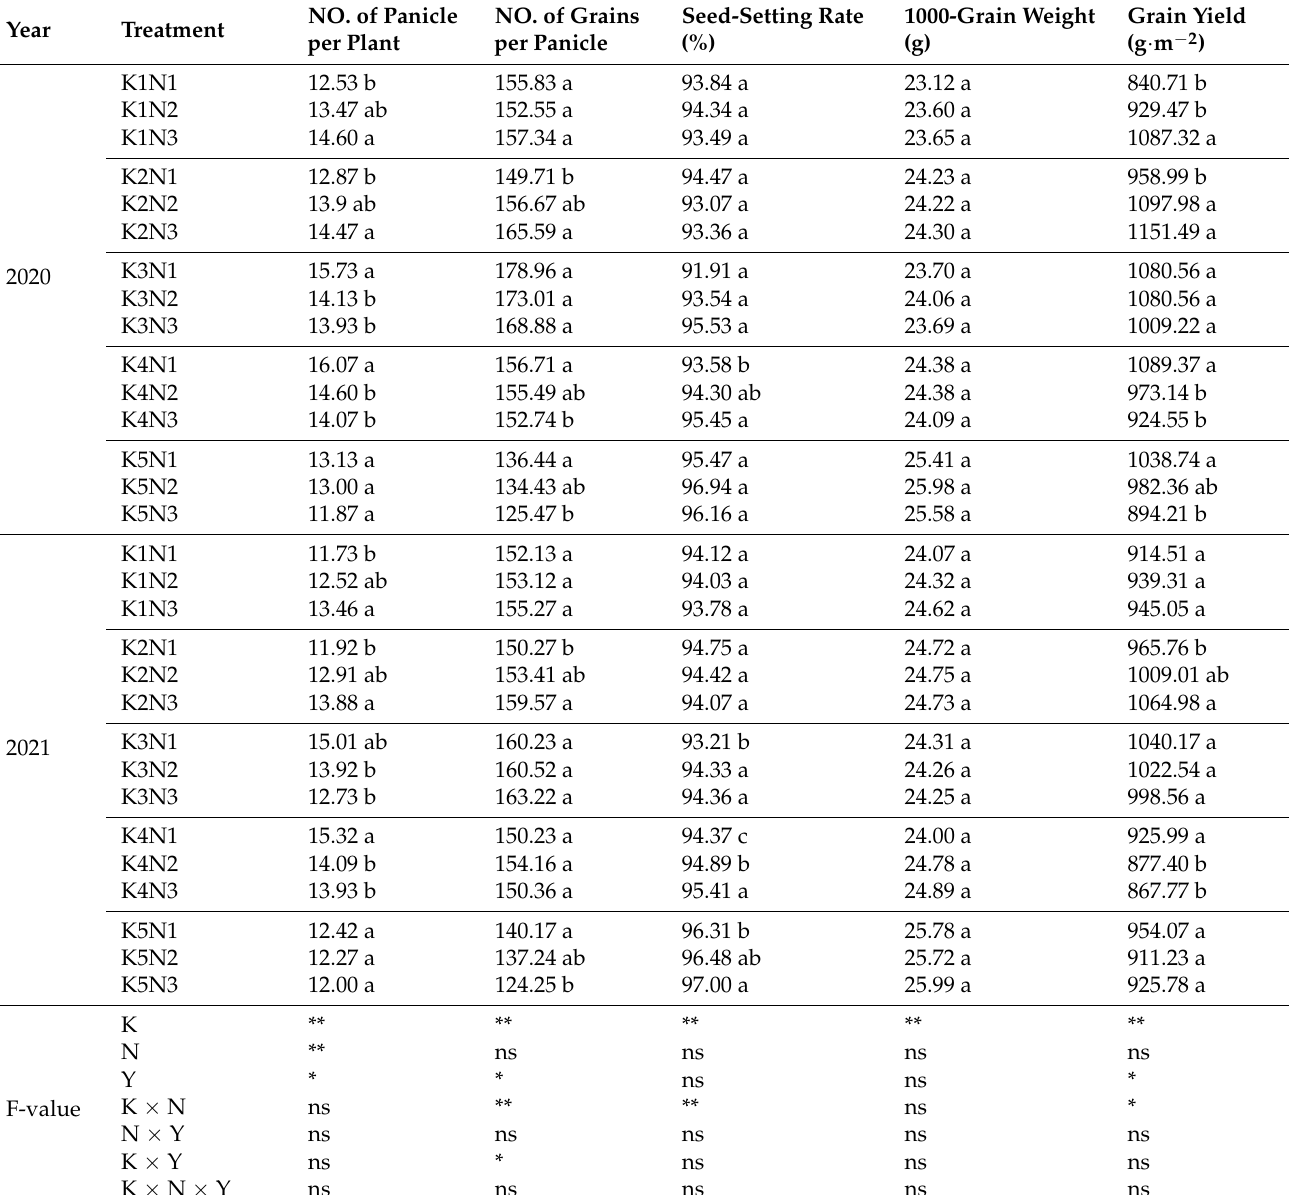
Table 2. Effects of different N, K, and Y combined application during the panicle stage on rice yield and yield components in 2020 and 2021, with the results of the three-way